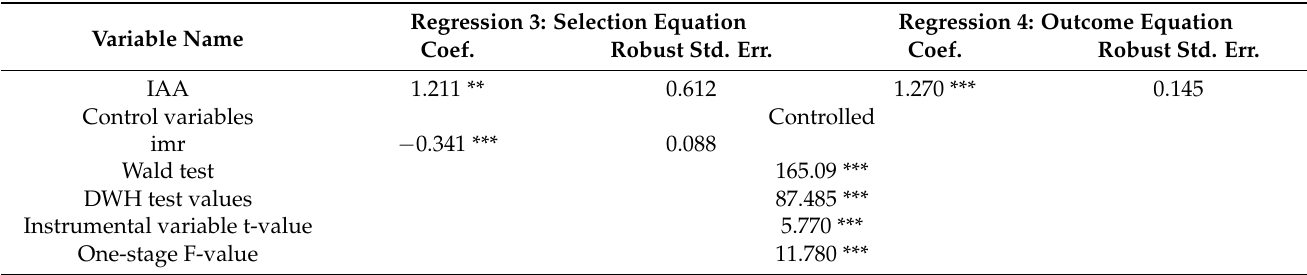
Table 6. Re-estimation results based on the IV-Heckman